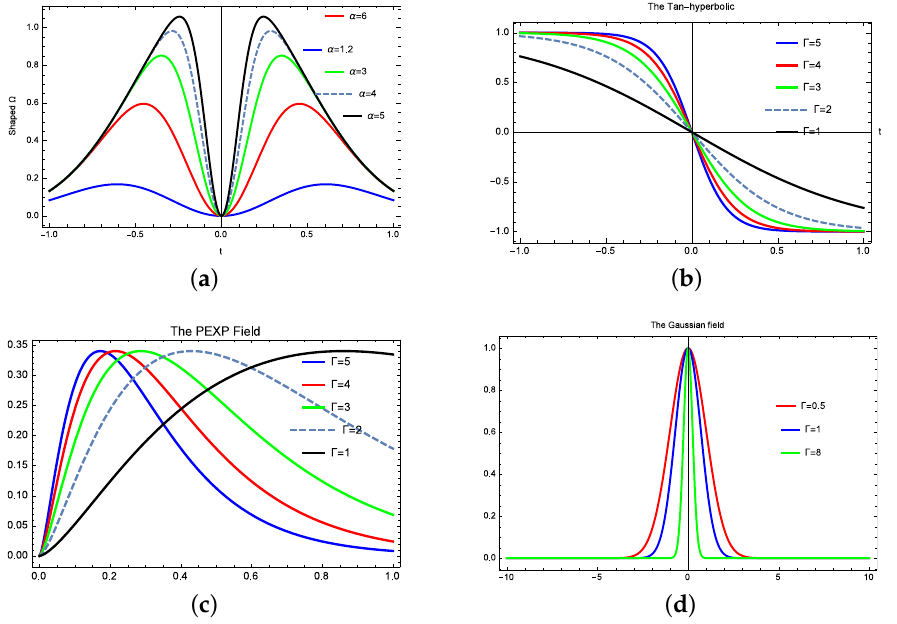
Figure 1. The microwave shaped field: ( a ) The double Gaussian pulse for various shape factor. ( b ) The tanh-hyperbolic pulse for various fall edge. ( c ) The power exponential pulse for various rise time. ( d ) The Gaussian pulse for various aperture